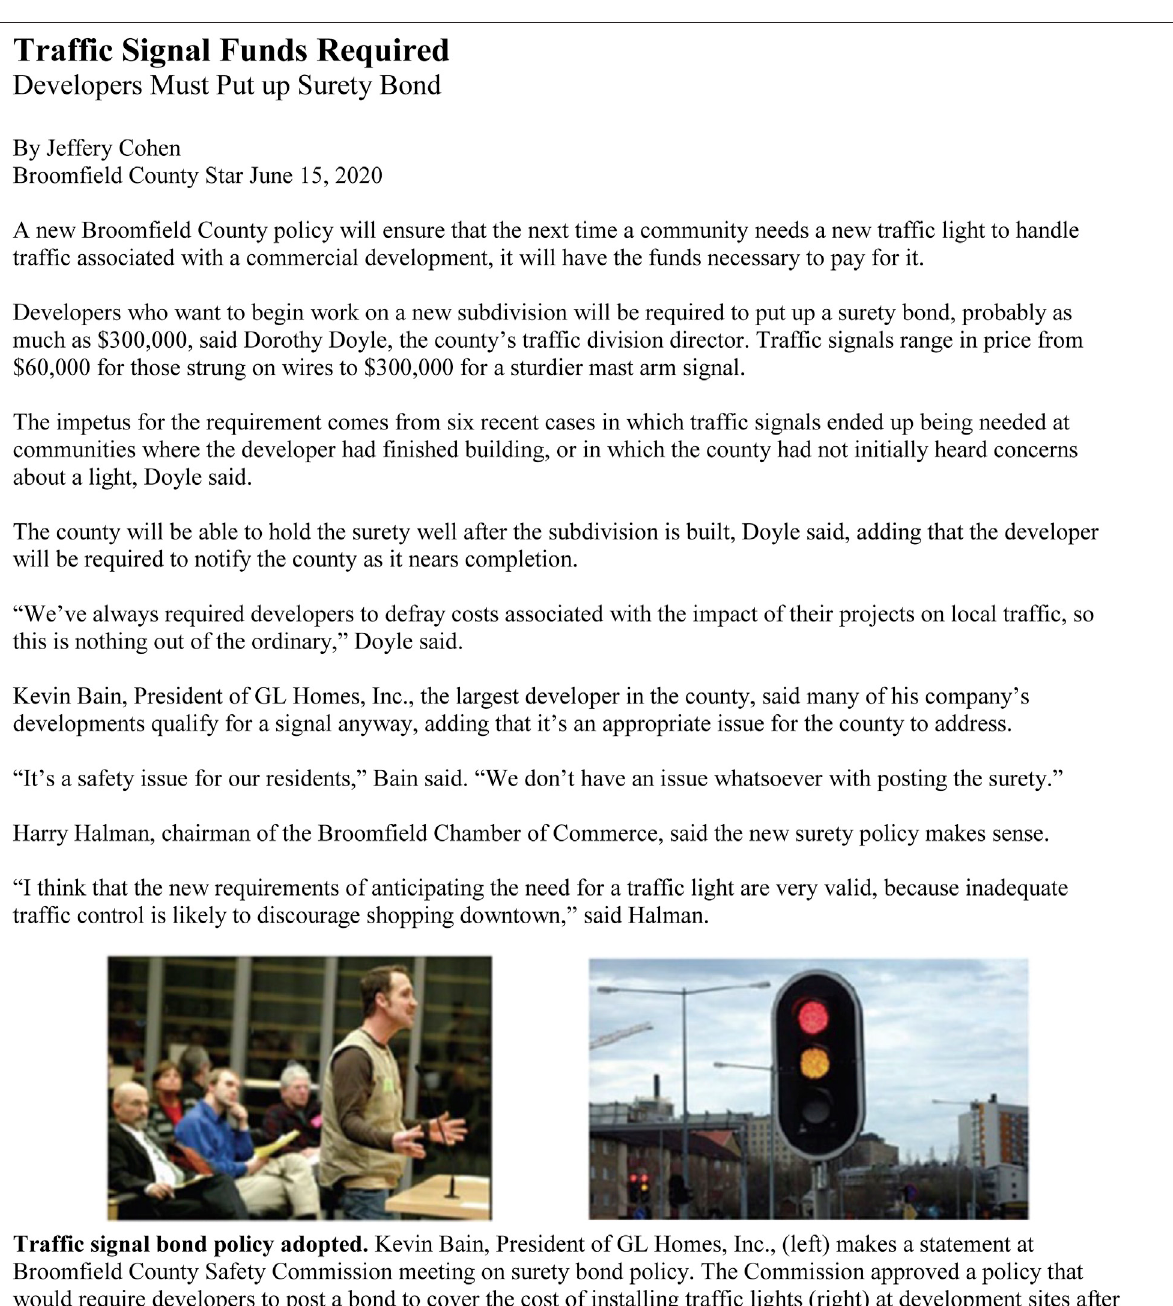
FIGURE 3 | Control article about funding for traf fi c lights free of cultural framing. Adapted from Kahan et al. (2015).